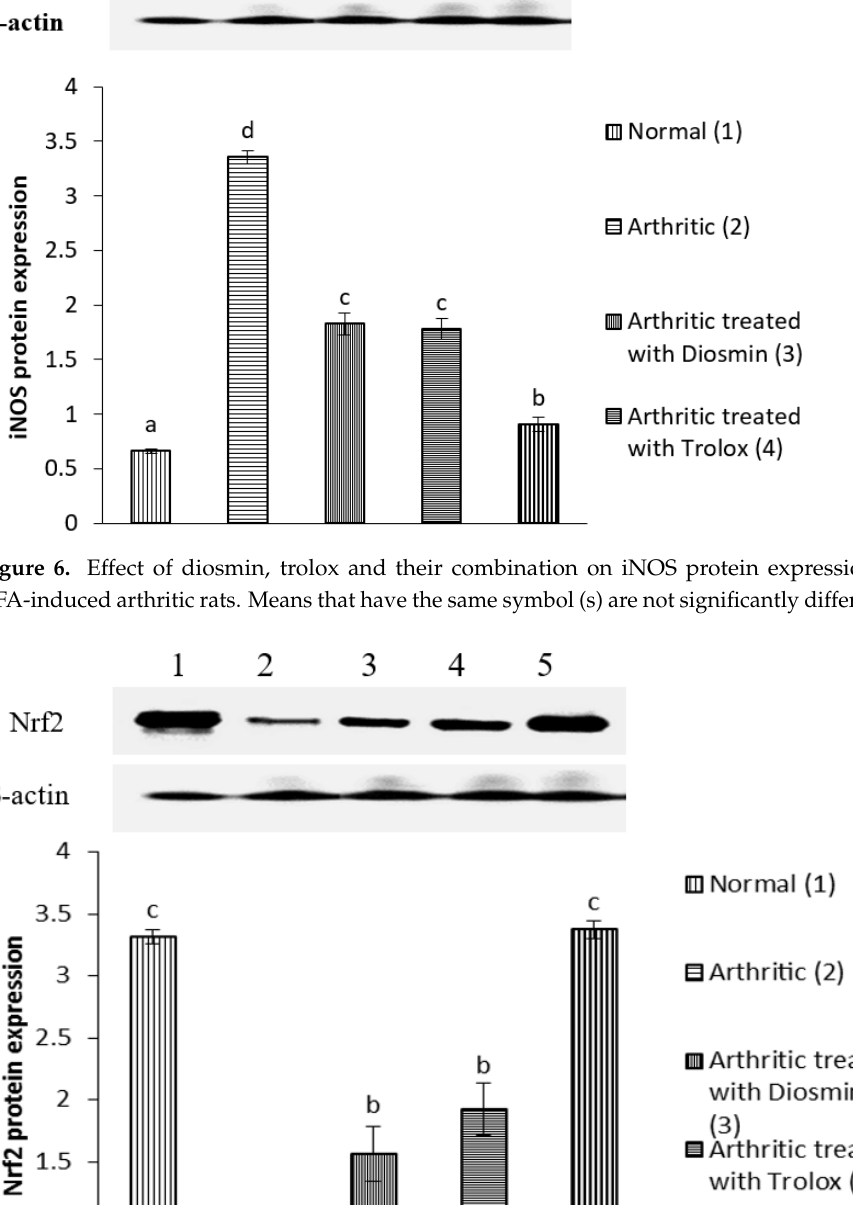
Figure 5. Effect of diosmin, trolox and their combination on NF-κB p65 protein expression level in CFA-induced arthritic rats. Means that have the same symbol (s) are not significantly different ( n = 3).